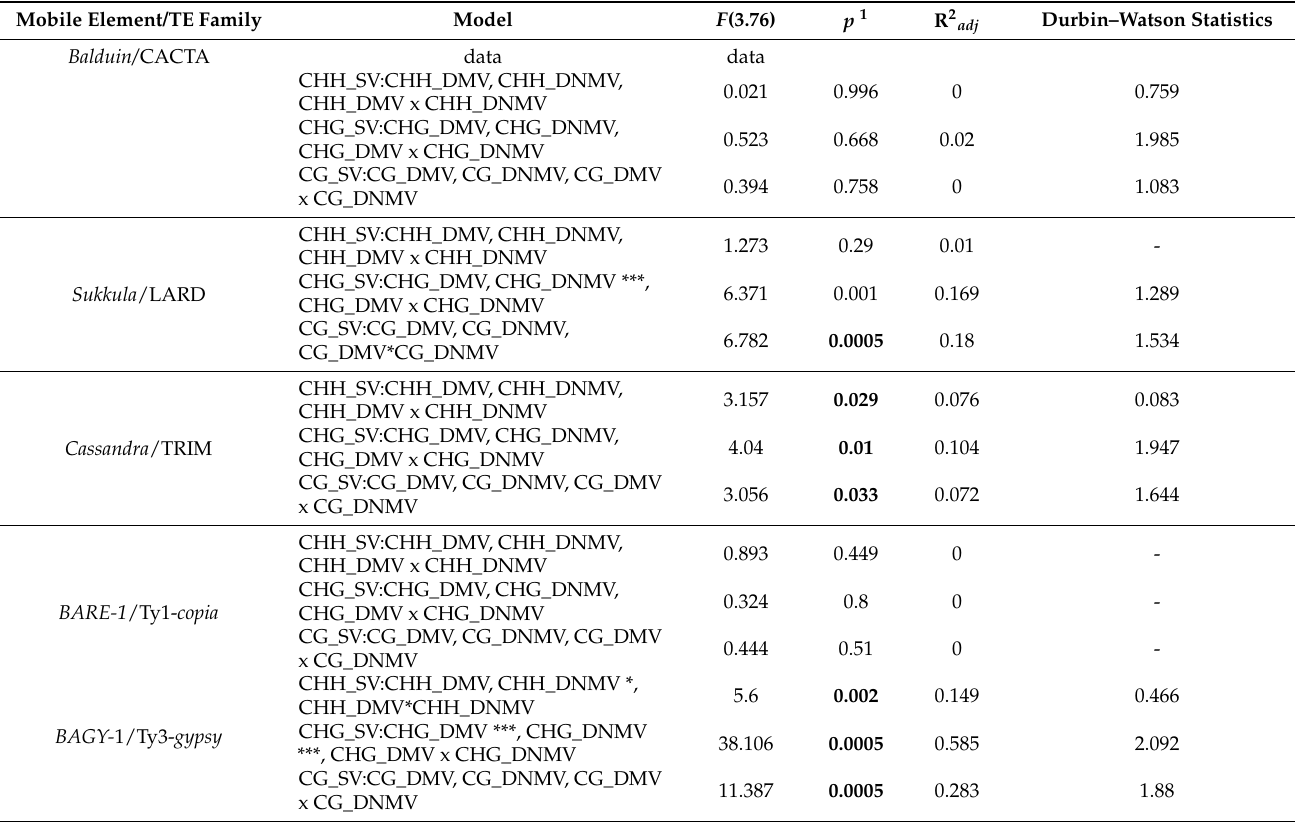
Table 6. Regression results verifying whether DNM and DNMV in different DNA sequence contexts explain sequence variation related to the respective TE